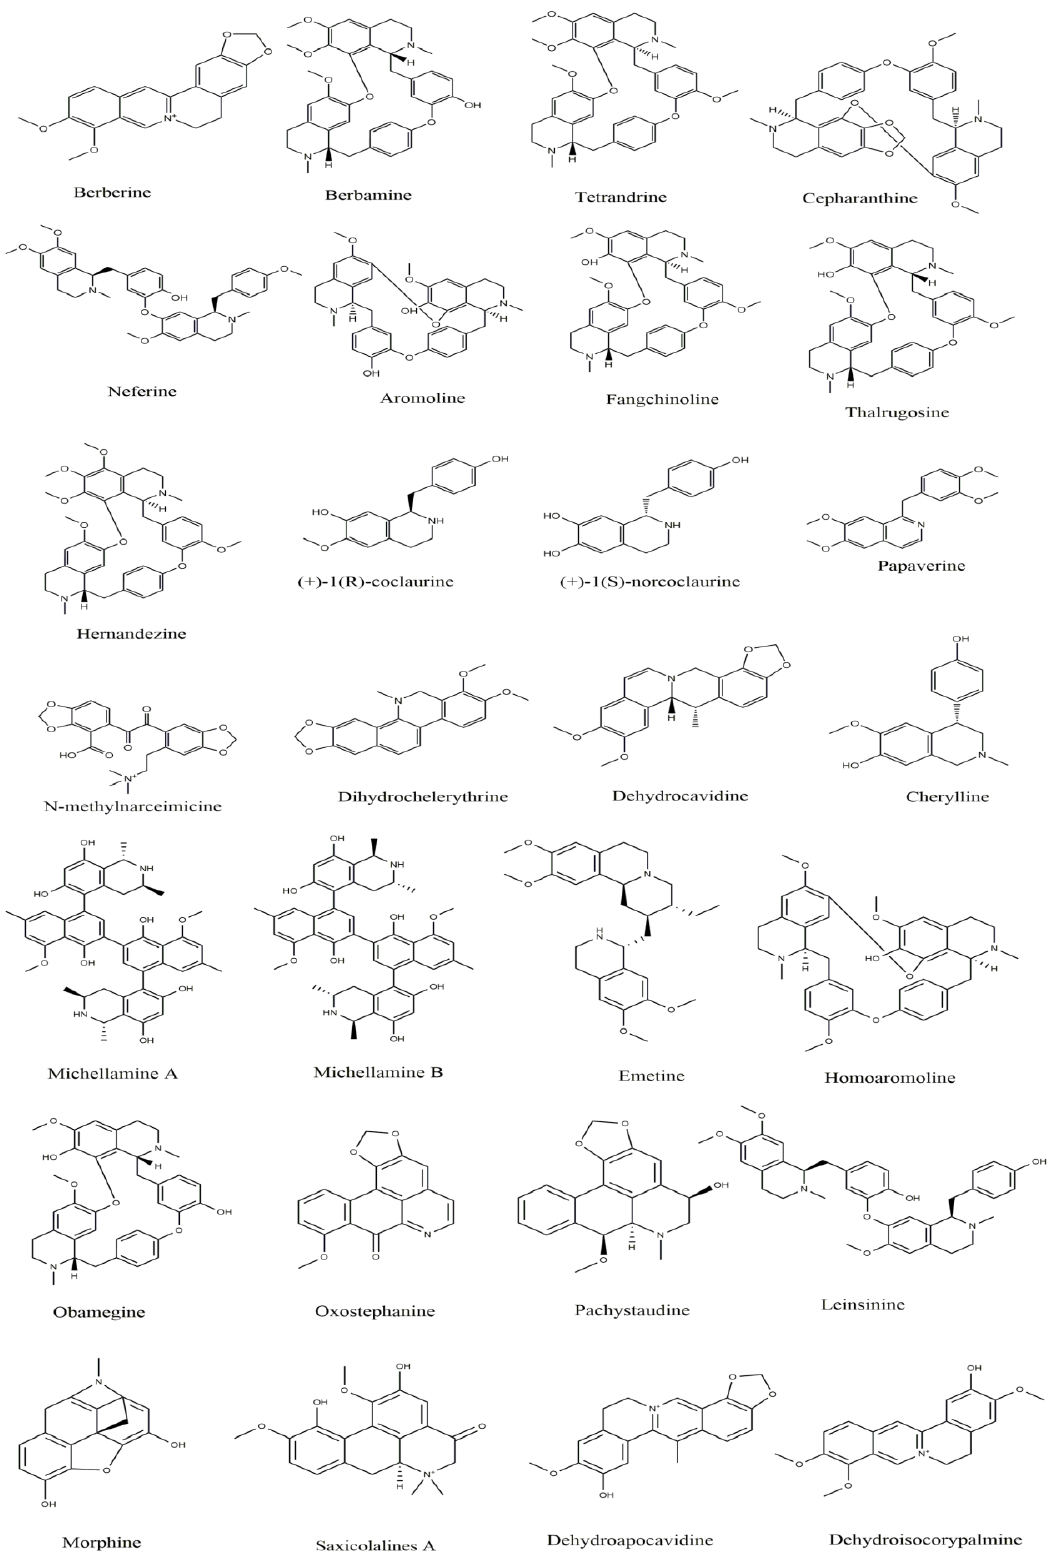
Figure 5. Chemical structures of isoquinoline and related alkaloids falling under various categories. Two isoquinoline alkaloids namely (+)-1(R)-coclaurine and (+)-1(S)-norcoclaurine from Nelumbo nucifera Gaertn showed EC 50 values of 0.8 and >0.8 µ g/mL respectively